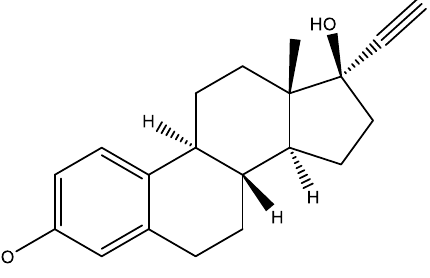
Figure 1. Structural formula of EE.